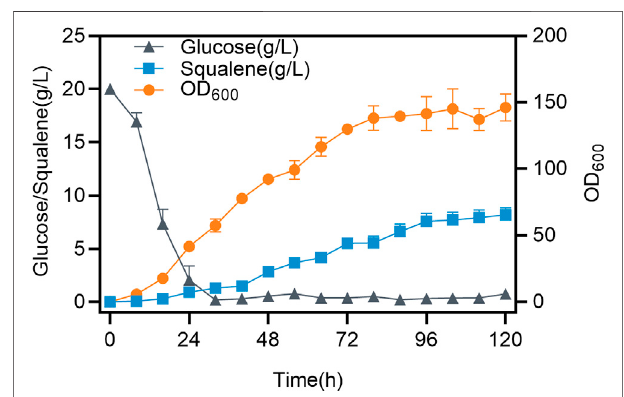
FIGURE 7 | Time course of squalene accumulation in a 5-L bioreactor. Time courses showing changes in squalene production and cell growth by strain SQ9 in a 5 L bioreactor. Error bars indicate SD